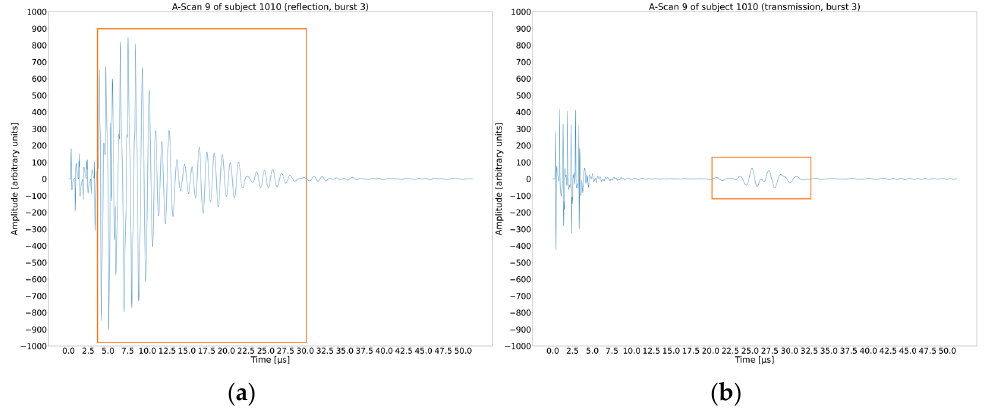
Figure 5. A-scan samples illustrating the reflection ( a ) and transmission ( b ) signals of the most distal element(s) acquired with a 3-cycle burst. The orange boxes indicate signal parts containing the most significant information.